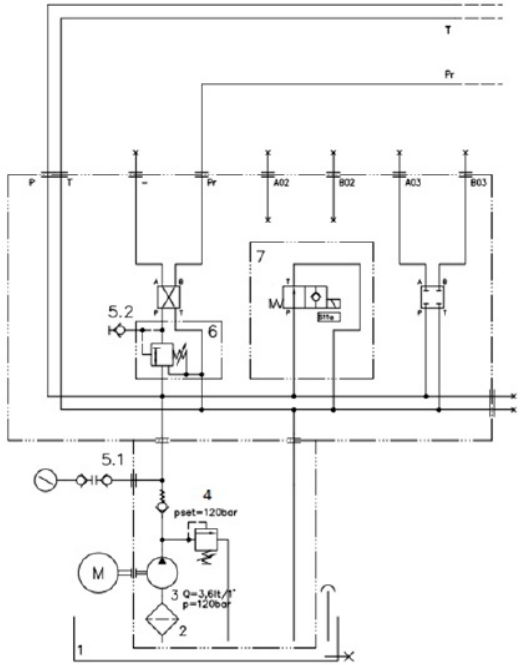
Figure 2. Hydraulic supply of